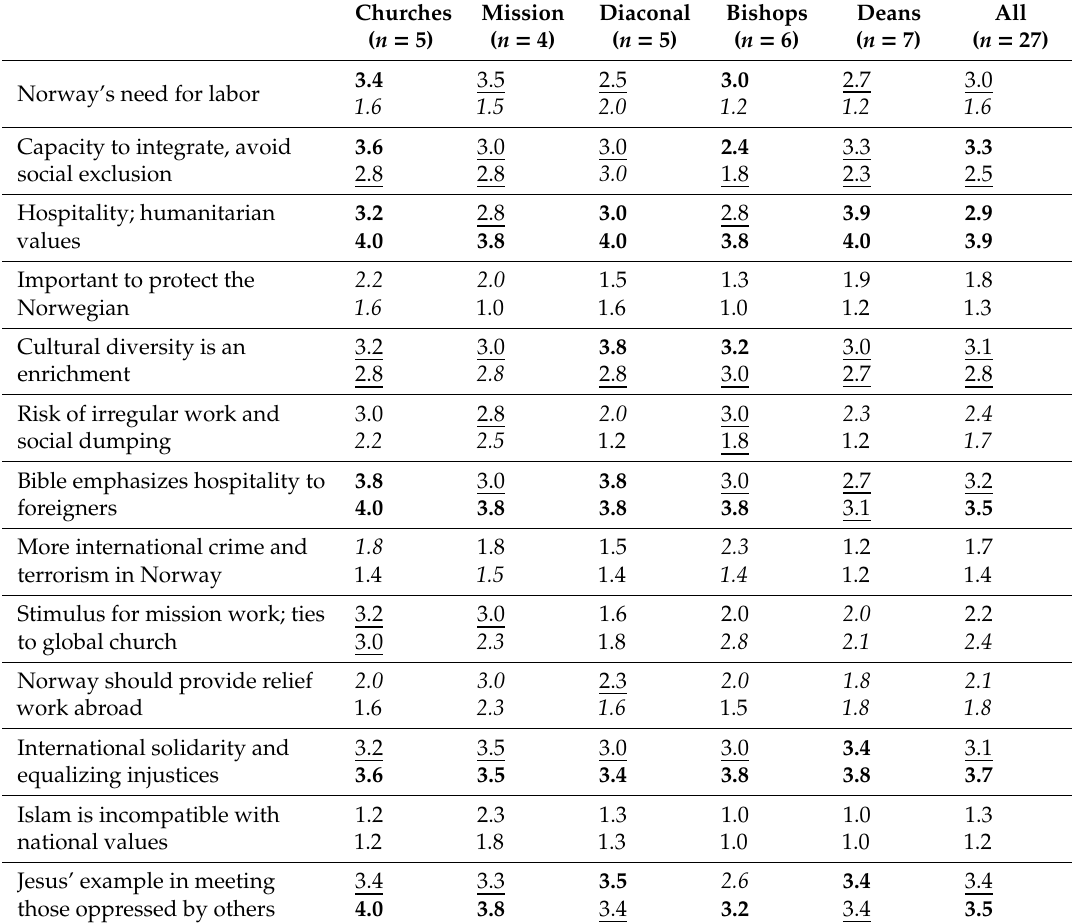
Table 1. Leaders’ Scores and Ranks to 13 Given